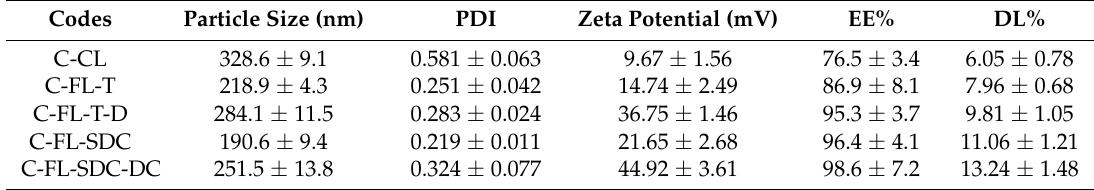
Table 4. Physicochemical characteristics of docetaxel (DXT)-loaded chitosomes.